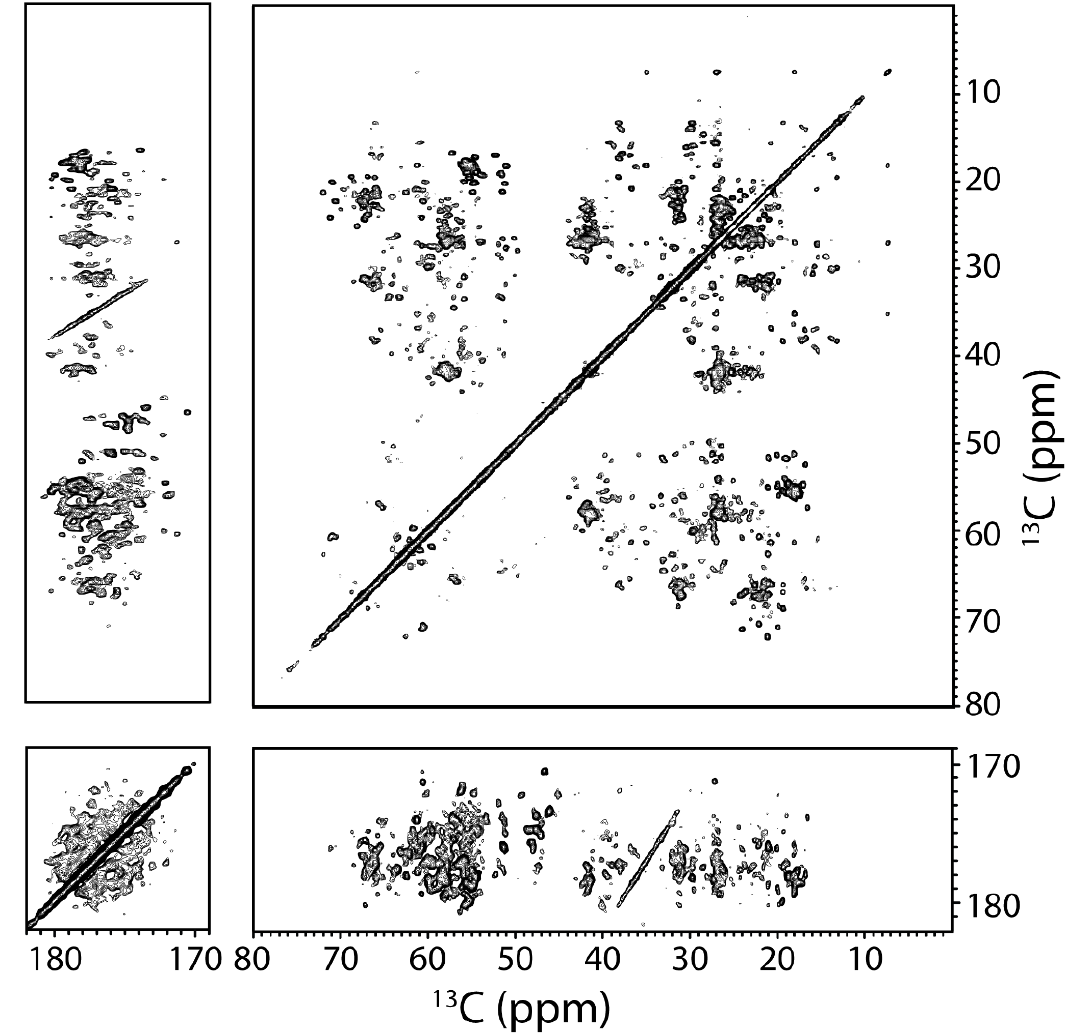
Figure 7. Two-dimensional 13 C– 13 C DARR chemical shift correlation spectrum of 13 C, 15 N-labeled hAQP2 proteolipid complexes at 800 MHz, at a spinning frequency of 14.3 kHz and at 5 °C. Mixing time was 13 ms. Data were processed with 40 Hz of Lorentzian line narrowing and 80 Hz of Gaussian line broadening in both dimensions. First contour level is cut at 5 × σ with each level multiplied by 1.15.